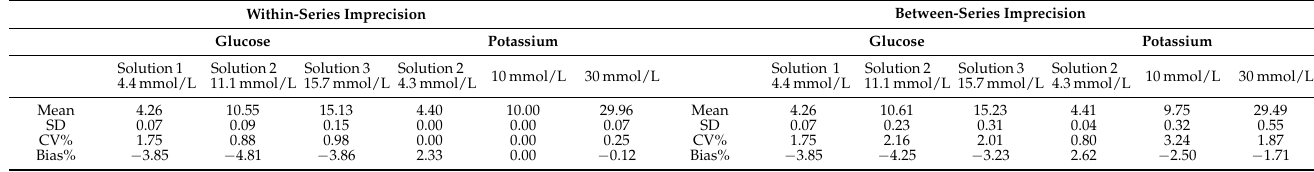
Table 1. Within-series and between-series imprecision of ABL90 flex instrument.